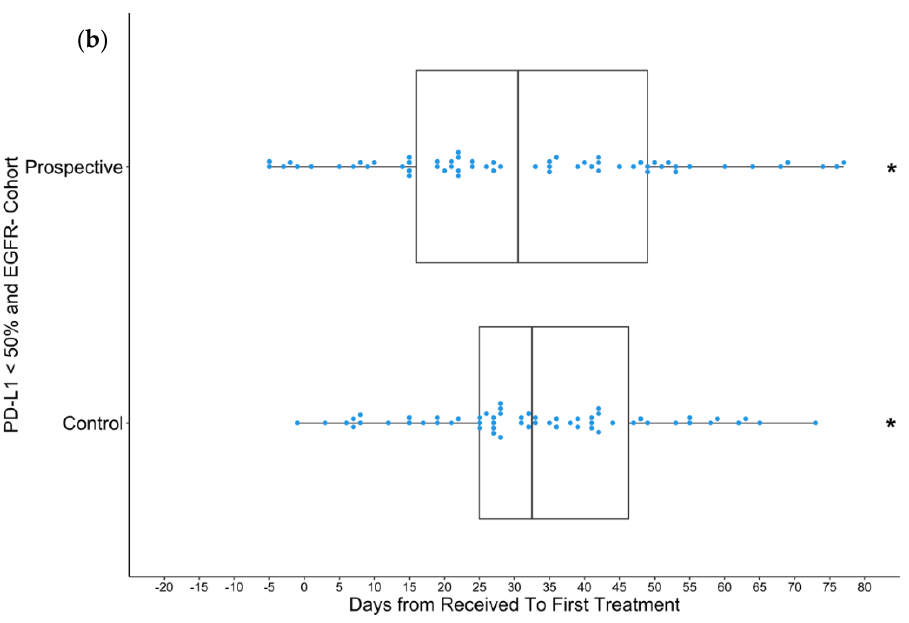
Figure 3. Boxplots visualize median, two hinges (25% and 75% quantiles), and two whiskers (95% CI). Black squares indicate outliers. Each blue dot represents an individual at a certain time-point. ( a ) The distribution of TTT of all patients treated based on PDL1 ≥ 50% in the control (N = 24) and trial (N = 19) cohorts. For the prospective trial cohort, the mean and median are 40.4 and 41 days, respectively. For the control cohort, the mean and median are 49.8 and 39.5 days, respectively. There is no statistically significant difference in means or medians. ( b ) The distribution of TTT of patients who received treatment based on PDL1 negativity and EGFR negativity in the control (N = 62) and trial (N = 62) cohorts. For the prospective trial cohort, the mean and median are 34.3 and 30.5 days, respectively. For the control cohort, the mean and median are 39.7 and 32.5 days, respectively. There is no statistically significant difference in means or medians. Asterisks indicate histograms with excluded data points.